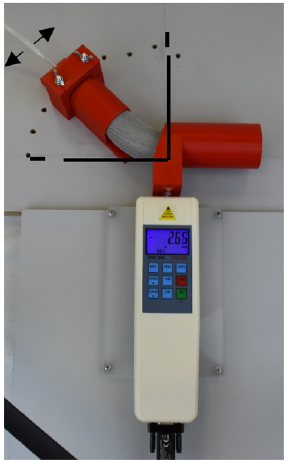
Figure A2. Output torque measurement setup.